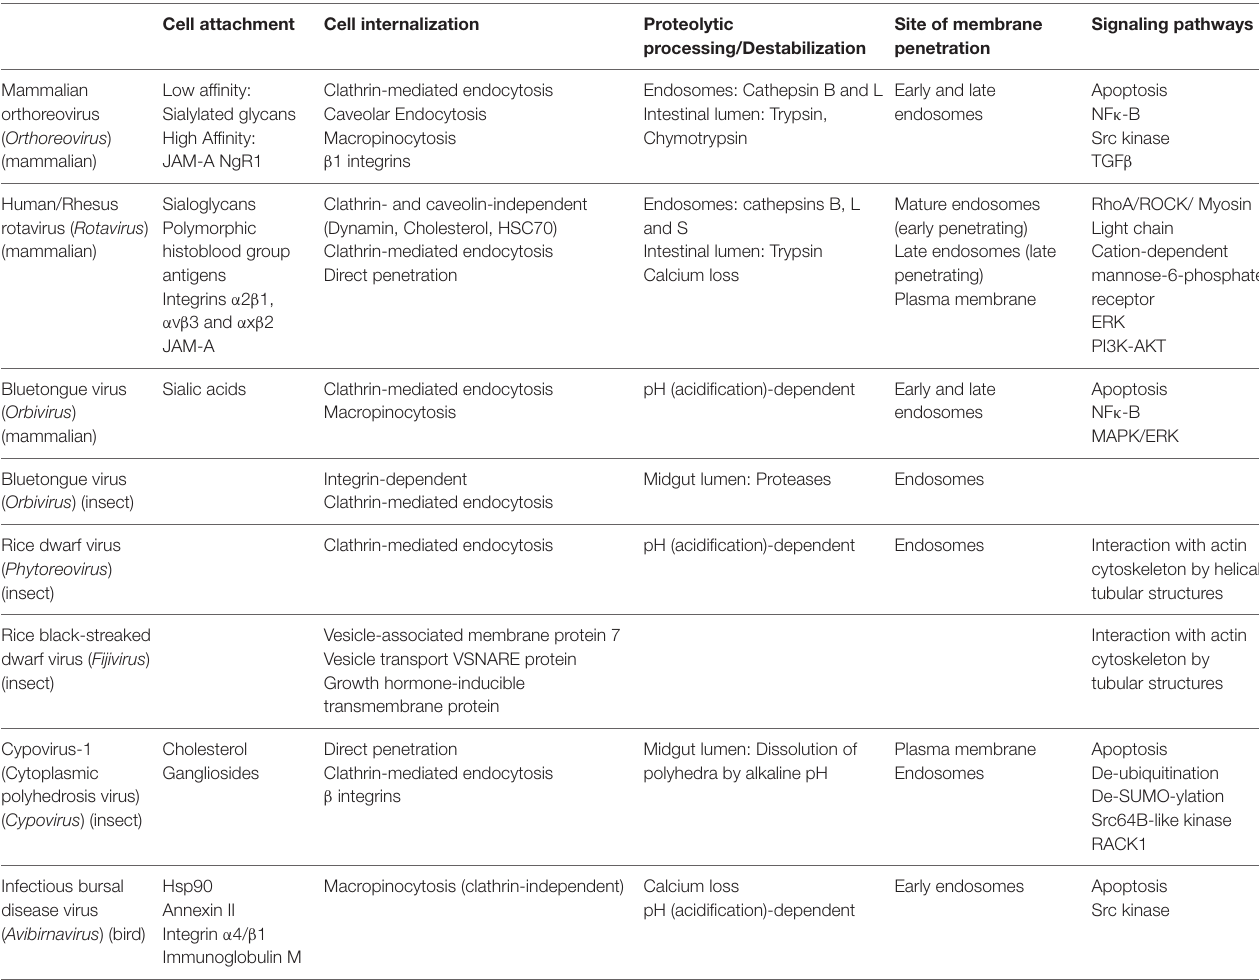
TABLE 1 | Overview of the molecular mechanisms of cellular entry by diverse dsRNA viruses. Cell attachment Cell internalization Proteolytic